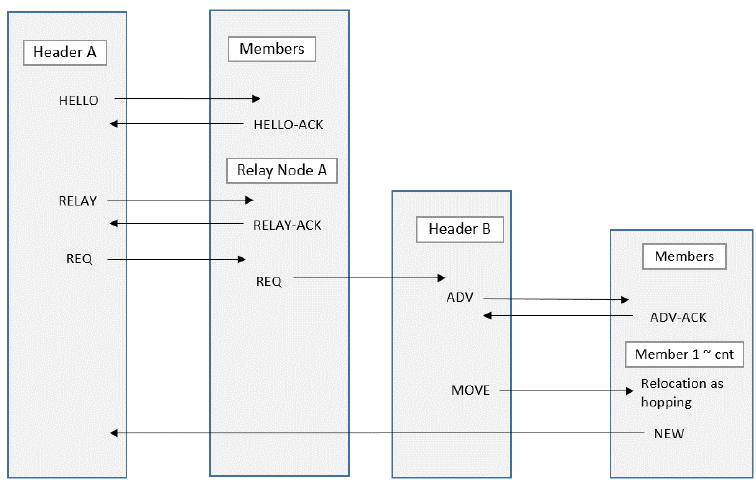
Figure 10. The message flow of the proposed hopping sensor relocation protocol.